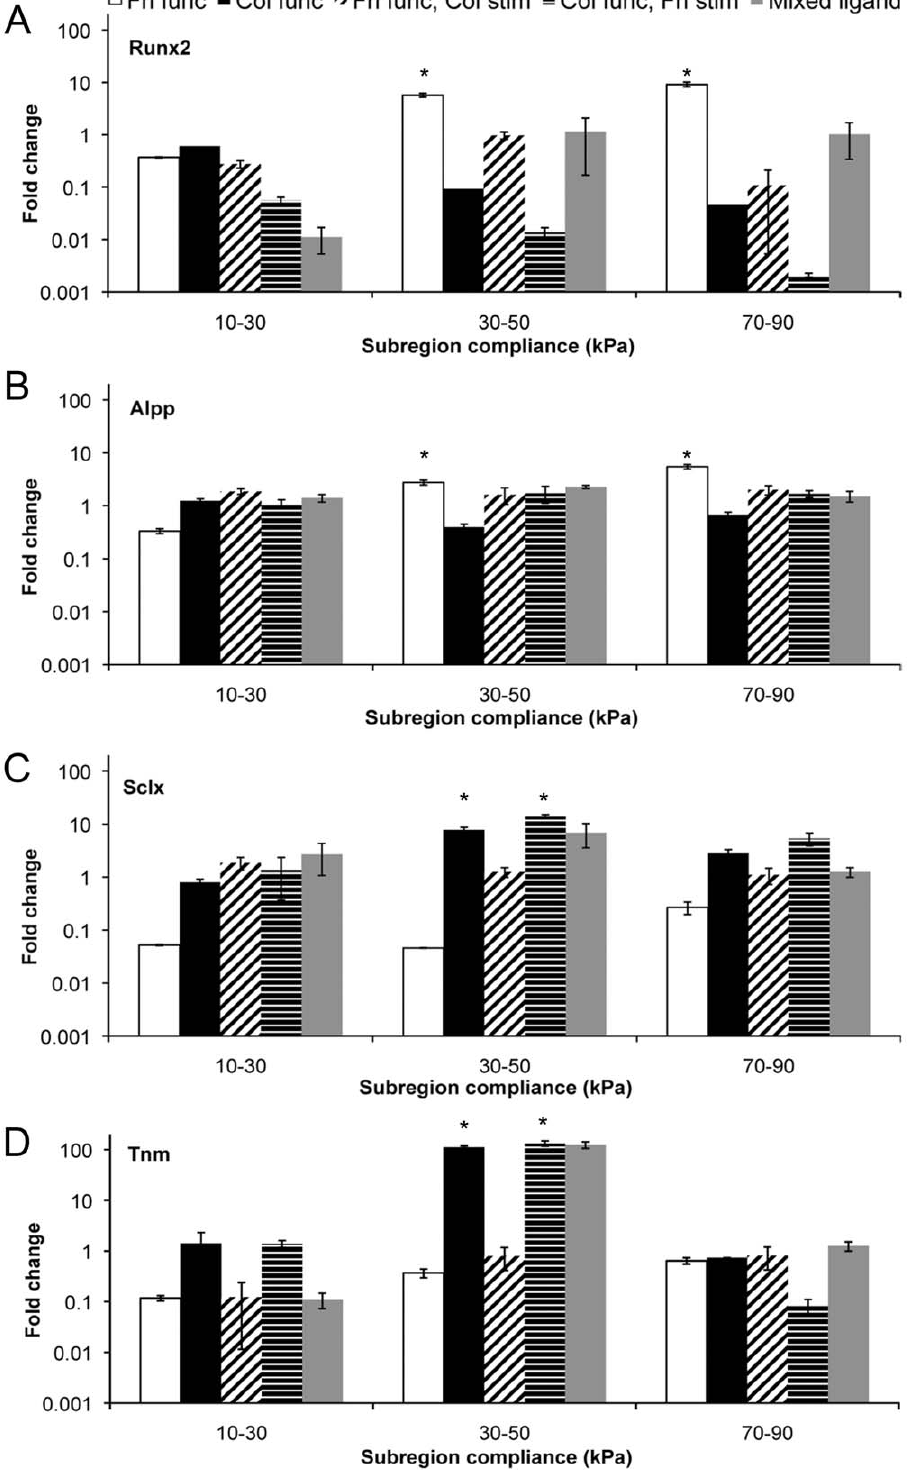
Figure 3. Markers of tenogenic and osteogenic differentiation from PCR. (A–B) Runx2 and alkaline phosphatase gene expression were similarly regulated, confirming the presence of osteogenic cells on fibronectin substrates in the intermediate and stiff subregions ( , 40 and , 80 kPa, respectively) of the intact MG10–90 substrate. (C–D) Scleraxis and tenomodulin expression confirmed tenogenic cells on the intermediate subregions of collagen functionalized substrates. * statistical difference (p , 0.05) compared to fold change from the MG10–90 substrate at , 20 kPa.